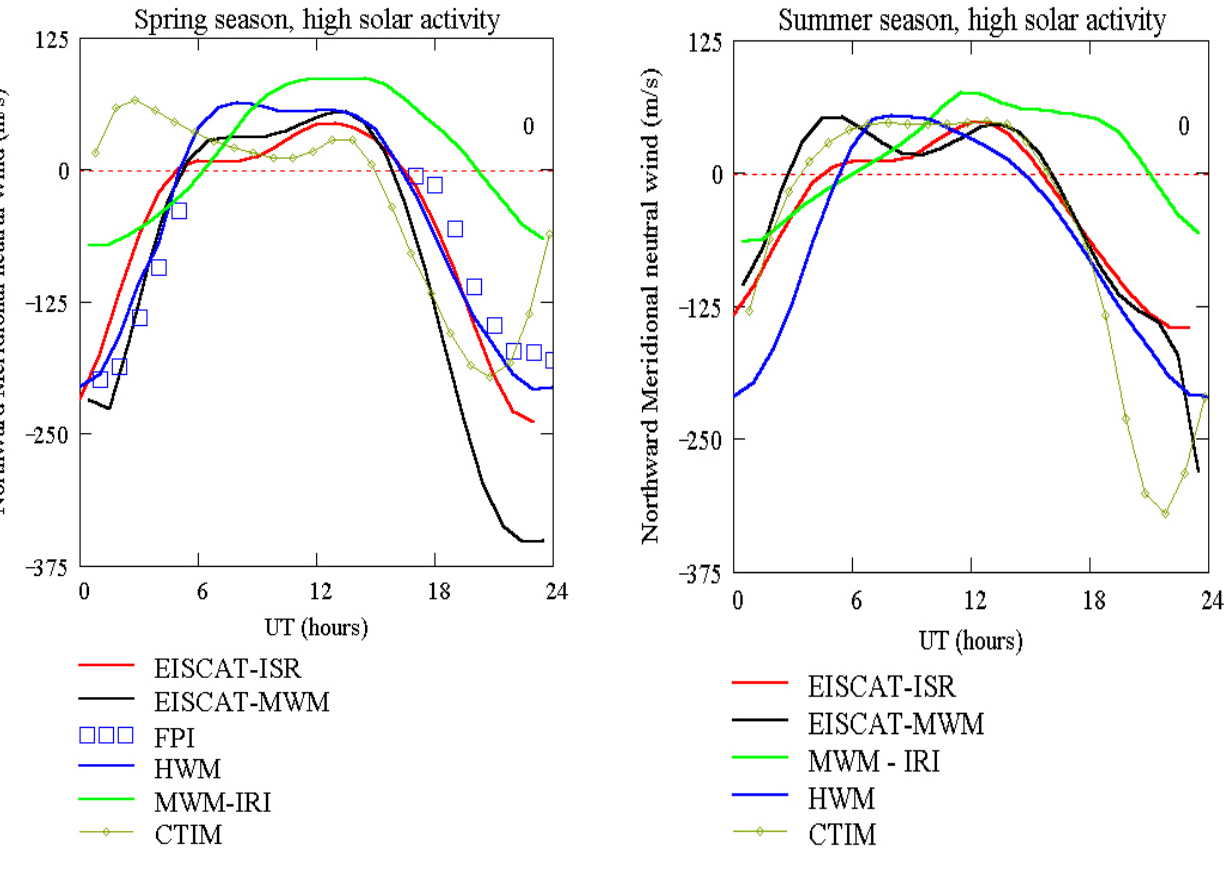
Fig. 5. As for Fig. 1 but for spring season, high solar activity. Table 5. As for Table 1 but for spring season, high solar activity.